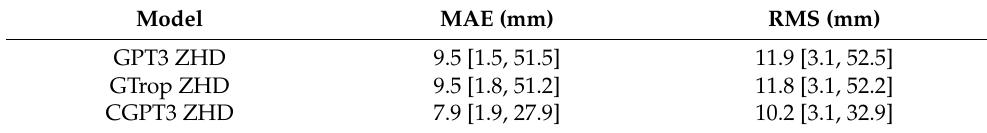
Table 3. Accuracy of ZHD derived from GPT3, GTrop, and CGPT3 models at 140 sites in 2017.